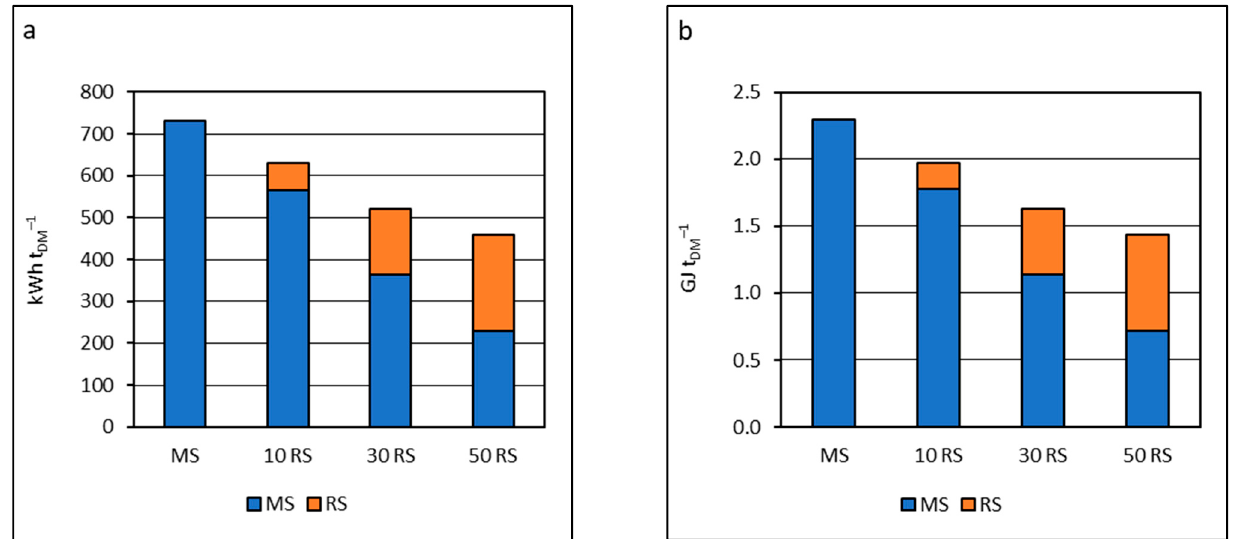
Figure 5. Electricity ( a ) and heat ( b ) produced by MS and RS in the analyzed combinations. MS—maize silage, 10 RS—maize silage with 10% content of reed silage, 30 RS—maize silage with 30% content of reed silage, 50 RS—maize silage with 50% content of reed silage, and RS—reed silage.